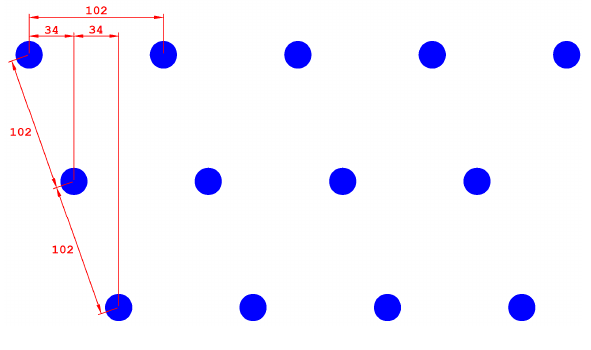
Figure 11. Wave farm layout.